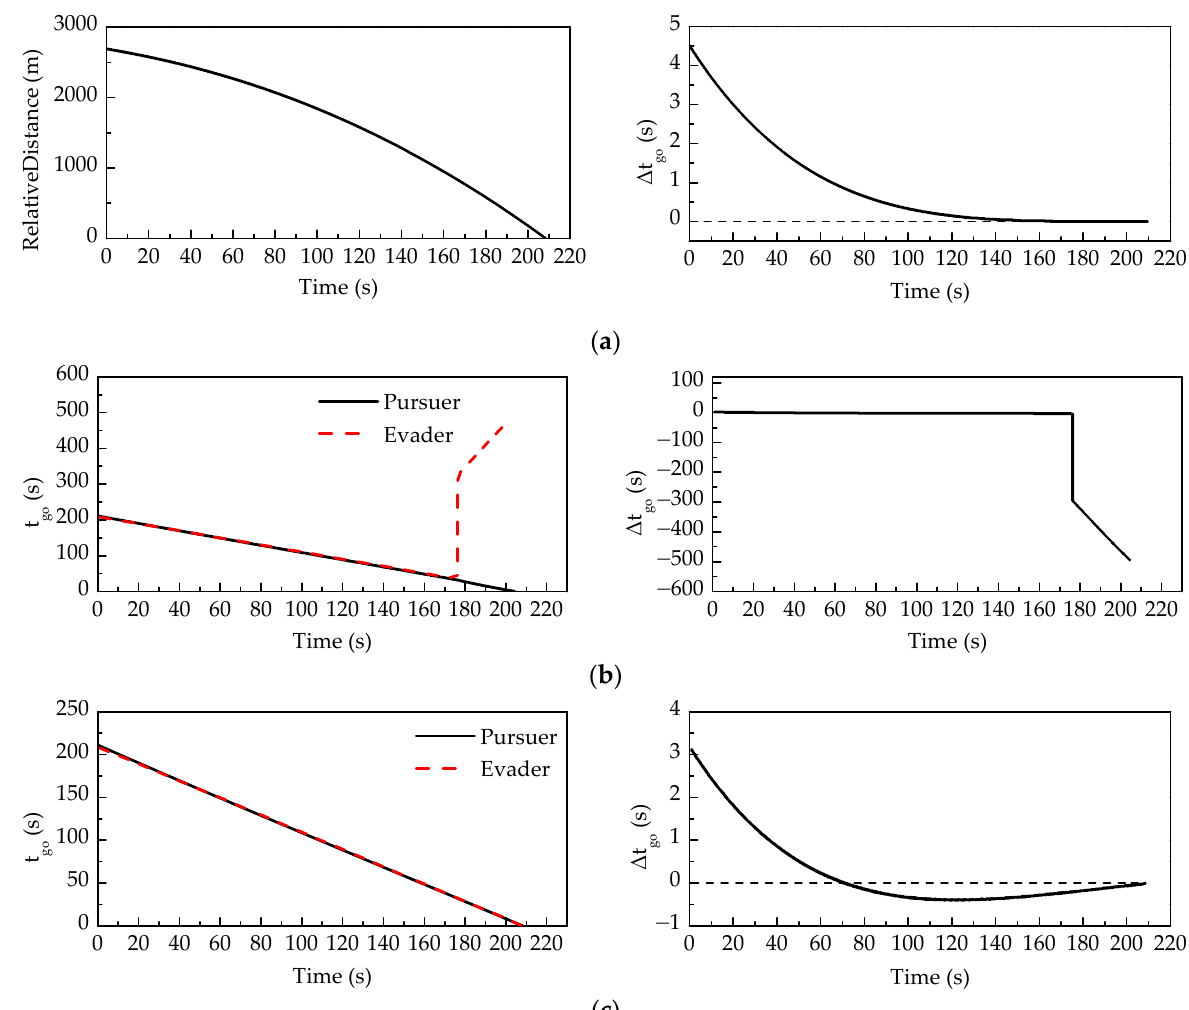
Figure 13. The average t go and ∆ t go of 100 Monte Carlo runs in the scenario that the evader plays ( a ) without time delay; ( b ) without compensation for time delay; and ( c ) with compensation for time delay.